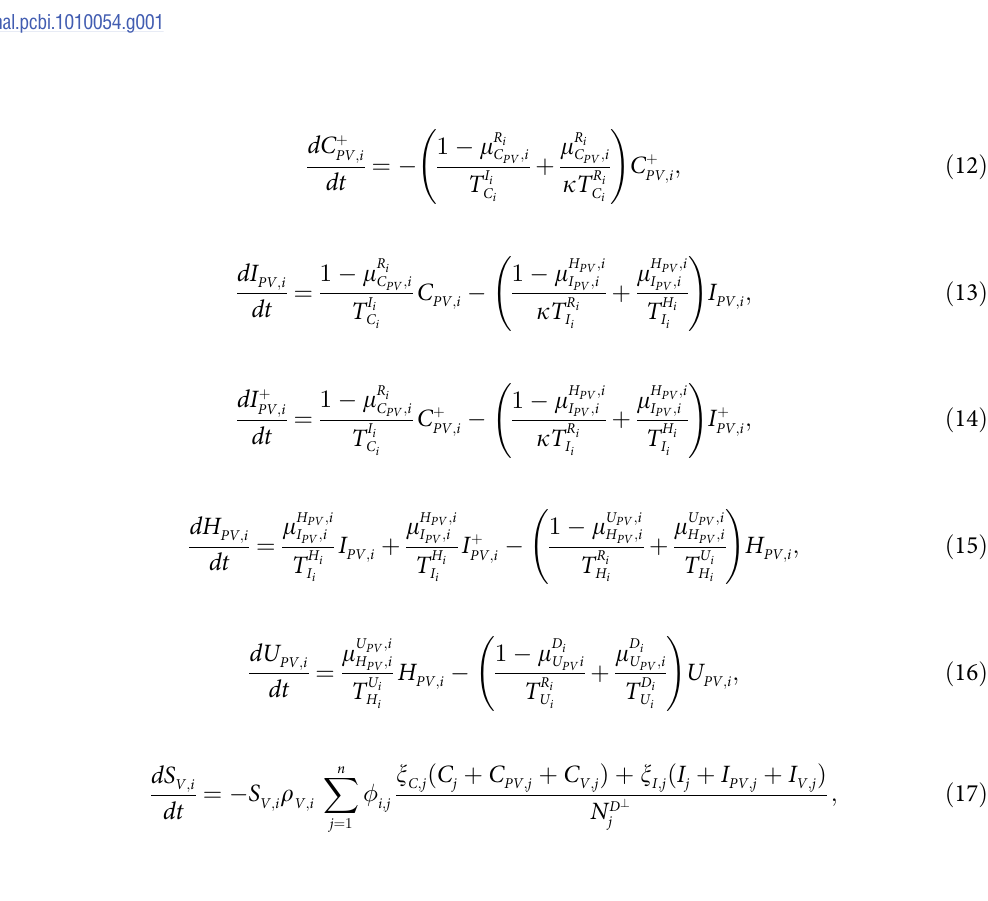
Fig 1. Local SIR-type model with vaccinations. We omit the age-dependence index i as well as the compartments C + and I + which do not have inflow from other compartments. The blue and green boxes represent compartments that have been newly added for the vaccination model. Here, C C PV + C V and I A = I + I PV + I V